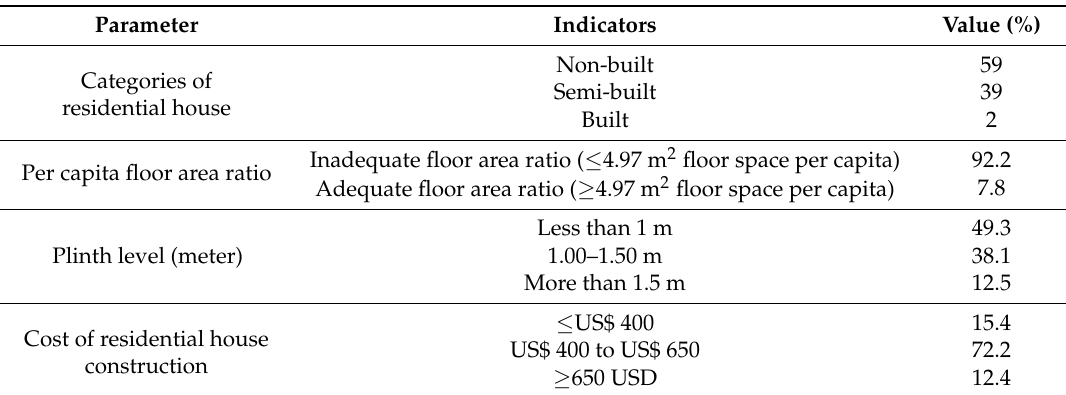
Table 4. Housing